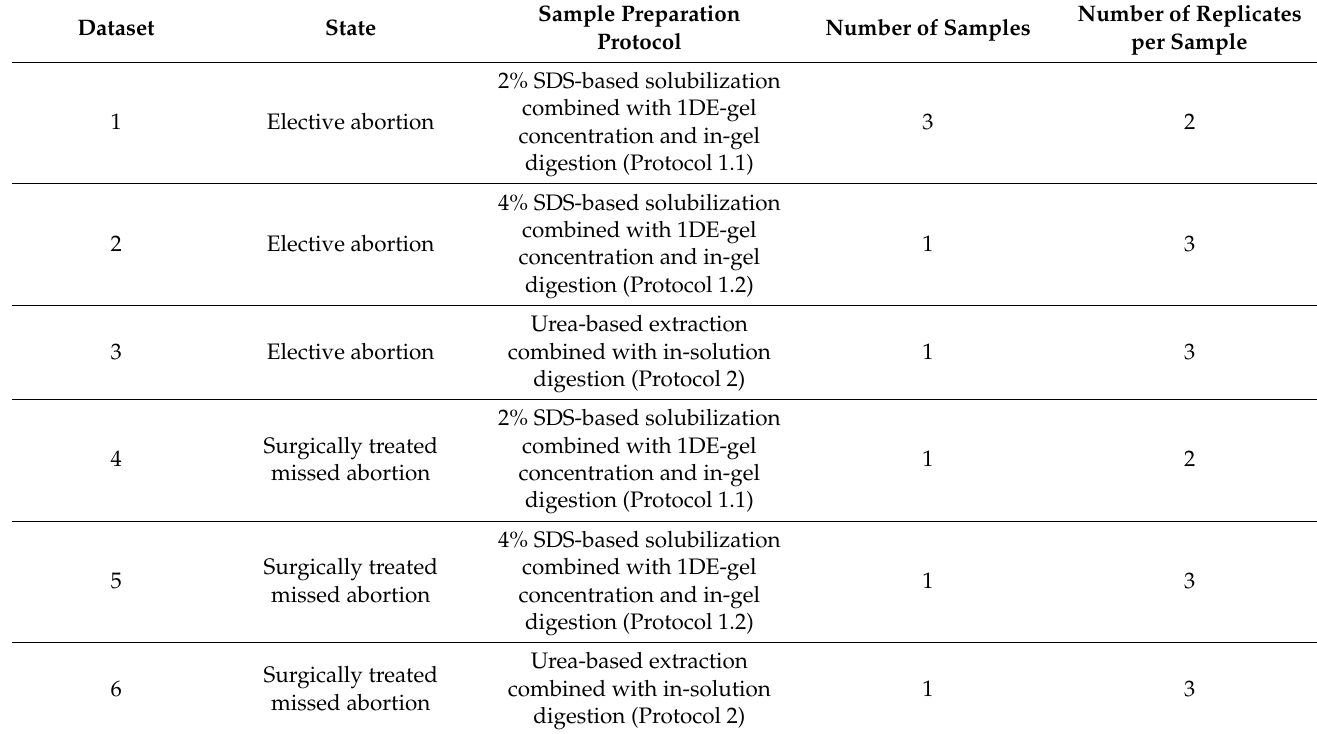
Table 1. Characterization of studied chorionic villus datasets prepared using different sample preparation